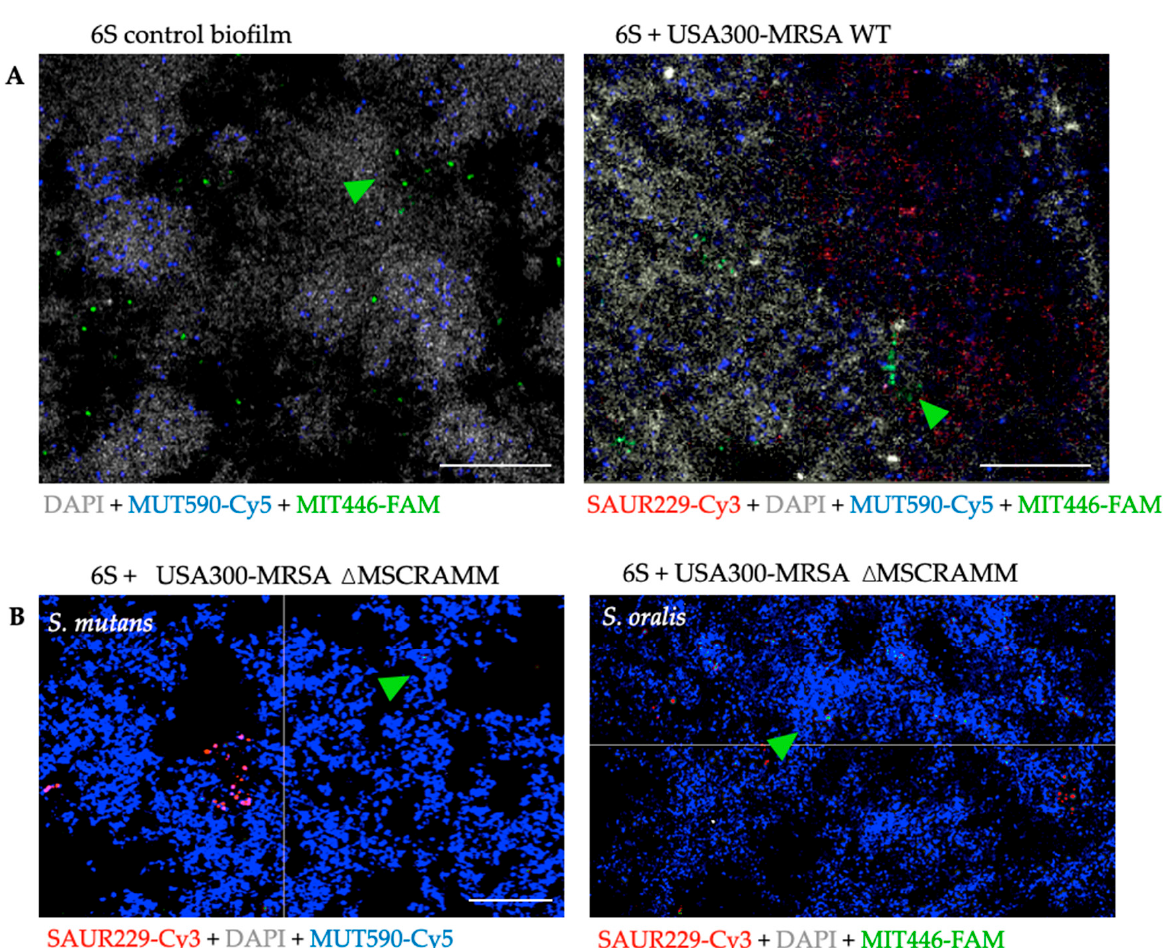
Figure 3. Localization of S. mutans and S. oralis within the biofilms. In ( A ), confocal-laser-scanning microscopy images of fluorescence in situ hybridization (FISH): biofilm cells shown in gray stained with DAPI, and S. aureus (USA300-MRSA WT and Δ MSCRAMM) stained with Saur229-Cy3 appear red. Due to MUT590-Cy5 staining, S. mutans appears blue and due to MIT446-FAM staining, S. oralis appears green. The thickness of the biofilm was 32.6 and 45.4 μ m, respectively. In ( B ), both images show the 6S biofilm with the implemented USA300-MRSA Δ MSCRAMM strain, presenting biofilm cells in blue. Arrows detail the green staining for S. mutans (MUT590-FAM) and S. oralis (MIT446-FAM). The thickness of the biofilm was 17.1 and 16.1 μ m. Scale = 20 μ m.